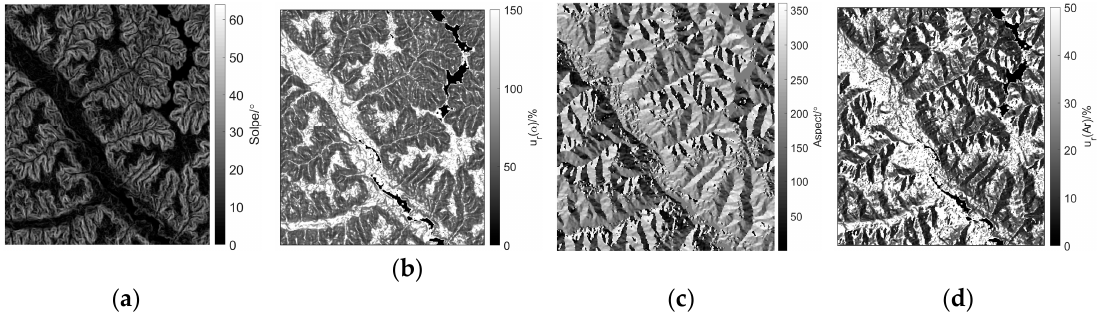
Figure 6. Visual images of ( a ) slope and ( b ) its relative uncertainty; visual images of ( c ) aspect and ( d ) its relative uncertainty.